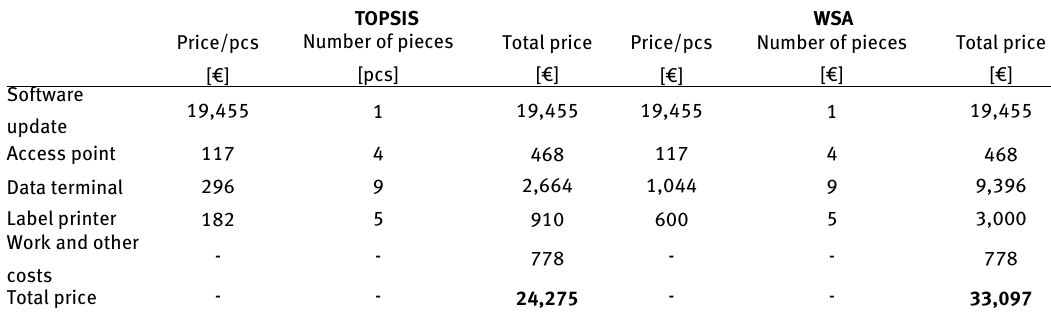
Table 7: Comparison of the results by the TOPSIS and WSA method TOPSIS WSA Price/pcs Number of